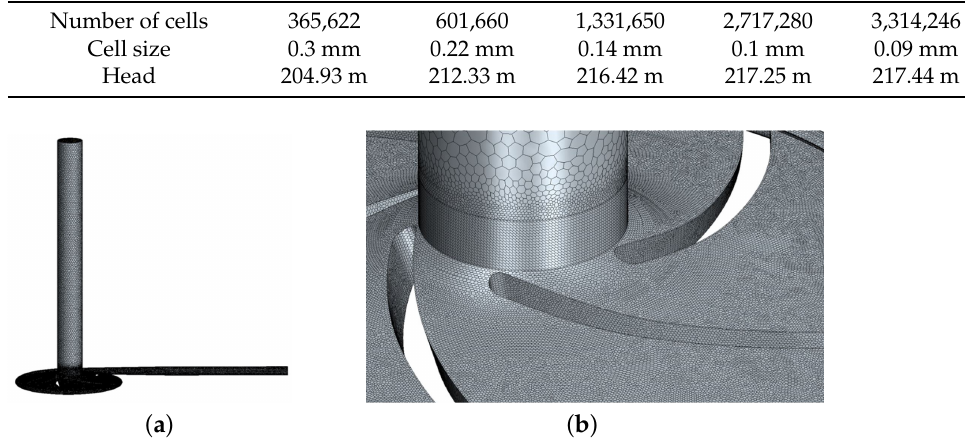
Figure 9. Grid configuration: ( a ) grid of the domain; ( b ) grid of the